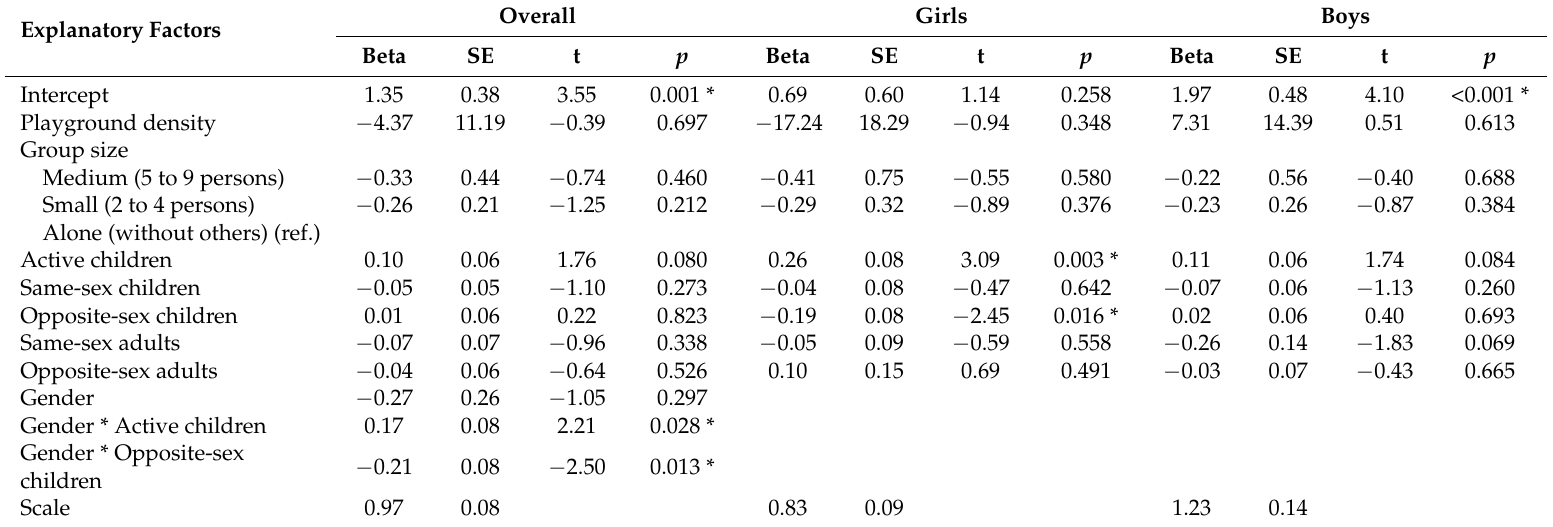
Table 3. Effects of the Social Environment on Moderate-to-Vigorous-Physical Activity in Children’s Playgrounds. Overall Girls Explanatory Factors